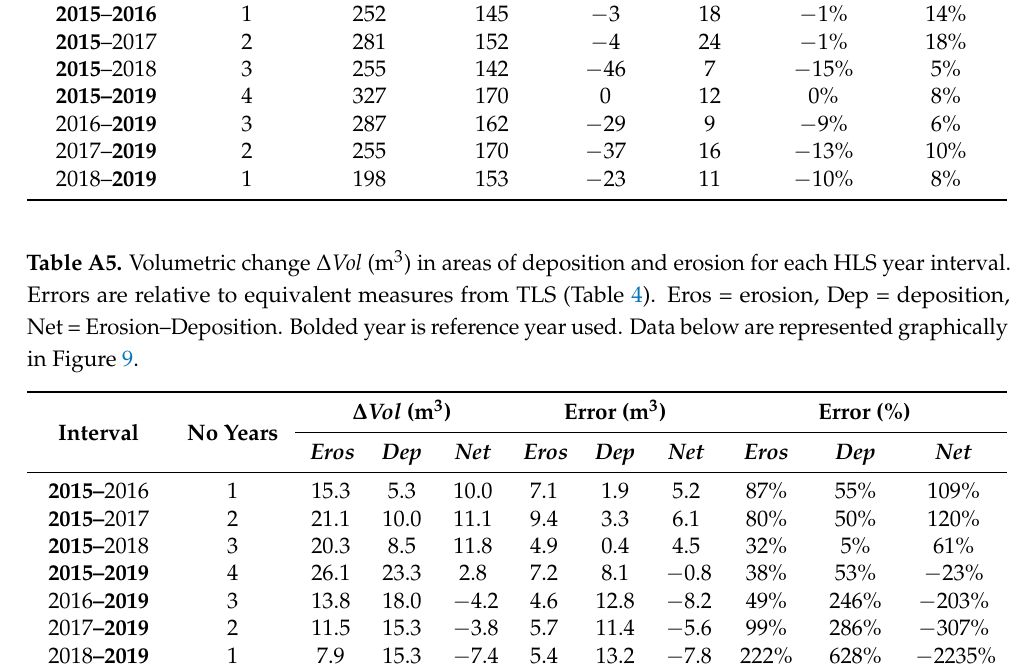
Table A4. Average depth Depth Avg in areas of deposition and erosion for each HLS year interval. Errors are relative to equivalent measures from TLS (Table 4). Eros = Areas of Erosion, Dep = Areas of Deposition. Bolded year is reference year used. Data below is represented graphically in Figure 9. Interval